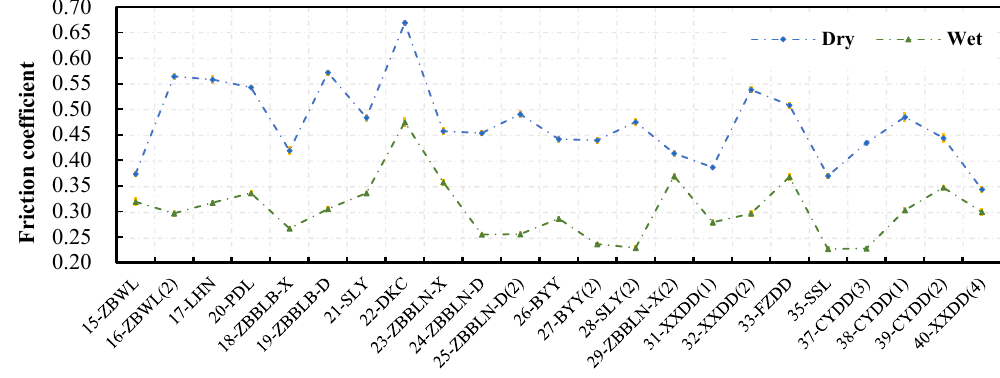
Figure 10. Friction coefficient measured under dry and wet conditions.